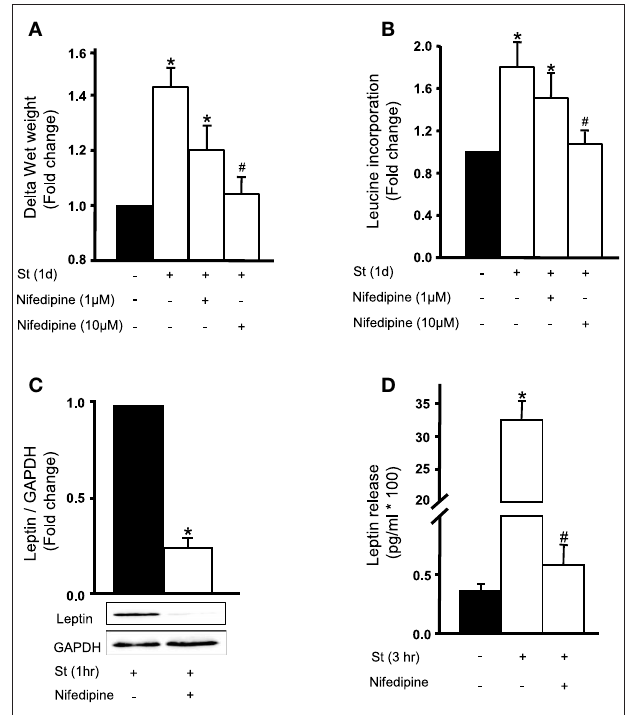
FIGURE 2 | Role of extracellular calcium in the mechanical stretch-mediated VSMC hypertrophy and leptin release. Nifedipine (1 or 10 µ M) inhibits mechanical stretch-induced (A) wet weight change and (B) protein synthesis in RPV. Nifedipine (10 µ M) significantly attenuated (C) leptin synthesis and (D) release after mechanical stretch for 1h in RPV ( n = 6–8). * p < 0.05 vs. unstretched. # p < 0.05 vs. St.